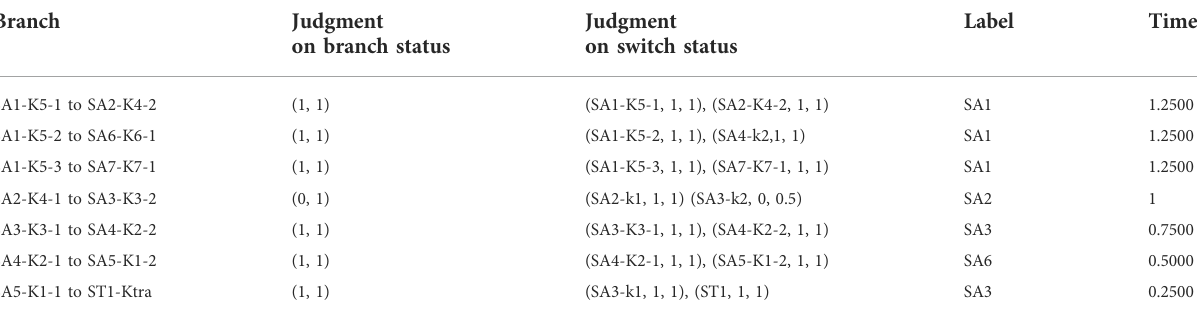
TABLE 8 Topology table of SA1 in Round